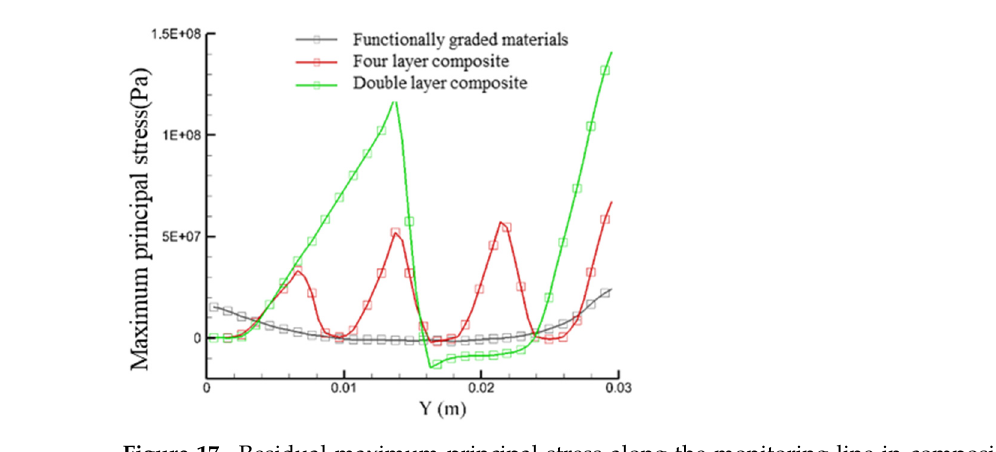
Figure 16. Residual maximum principal stress distribution in composite material and FGMs: ( a ) Double layer composite, ( b ) Four layer composite, ( c ) FGMs.